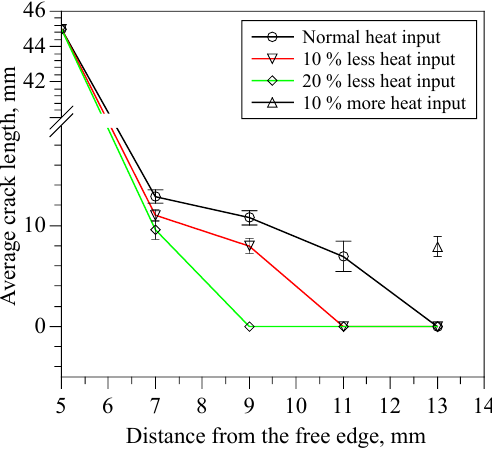
Figure 7. High speed camera images showing solidification cracking during welding. ( a ) Solidification crack initiating at the trailing edge of the mushy zone (5mm case); ( b ) full fracture observed (5mm case); and ( c ) the solidification crack stops propagating further (7mm case).